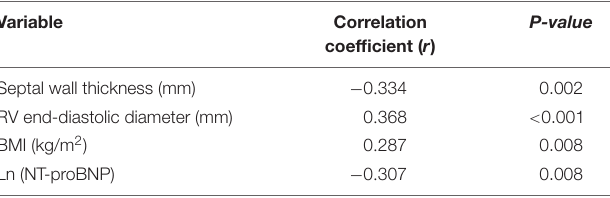
TABLE 3 | Correlation between clinical characteristics and plasma apelin levels of patients with obstructive hypertrophic cardiomyopathy.